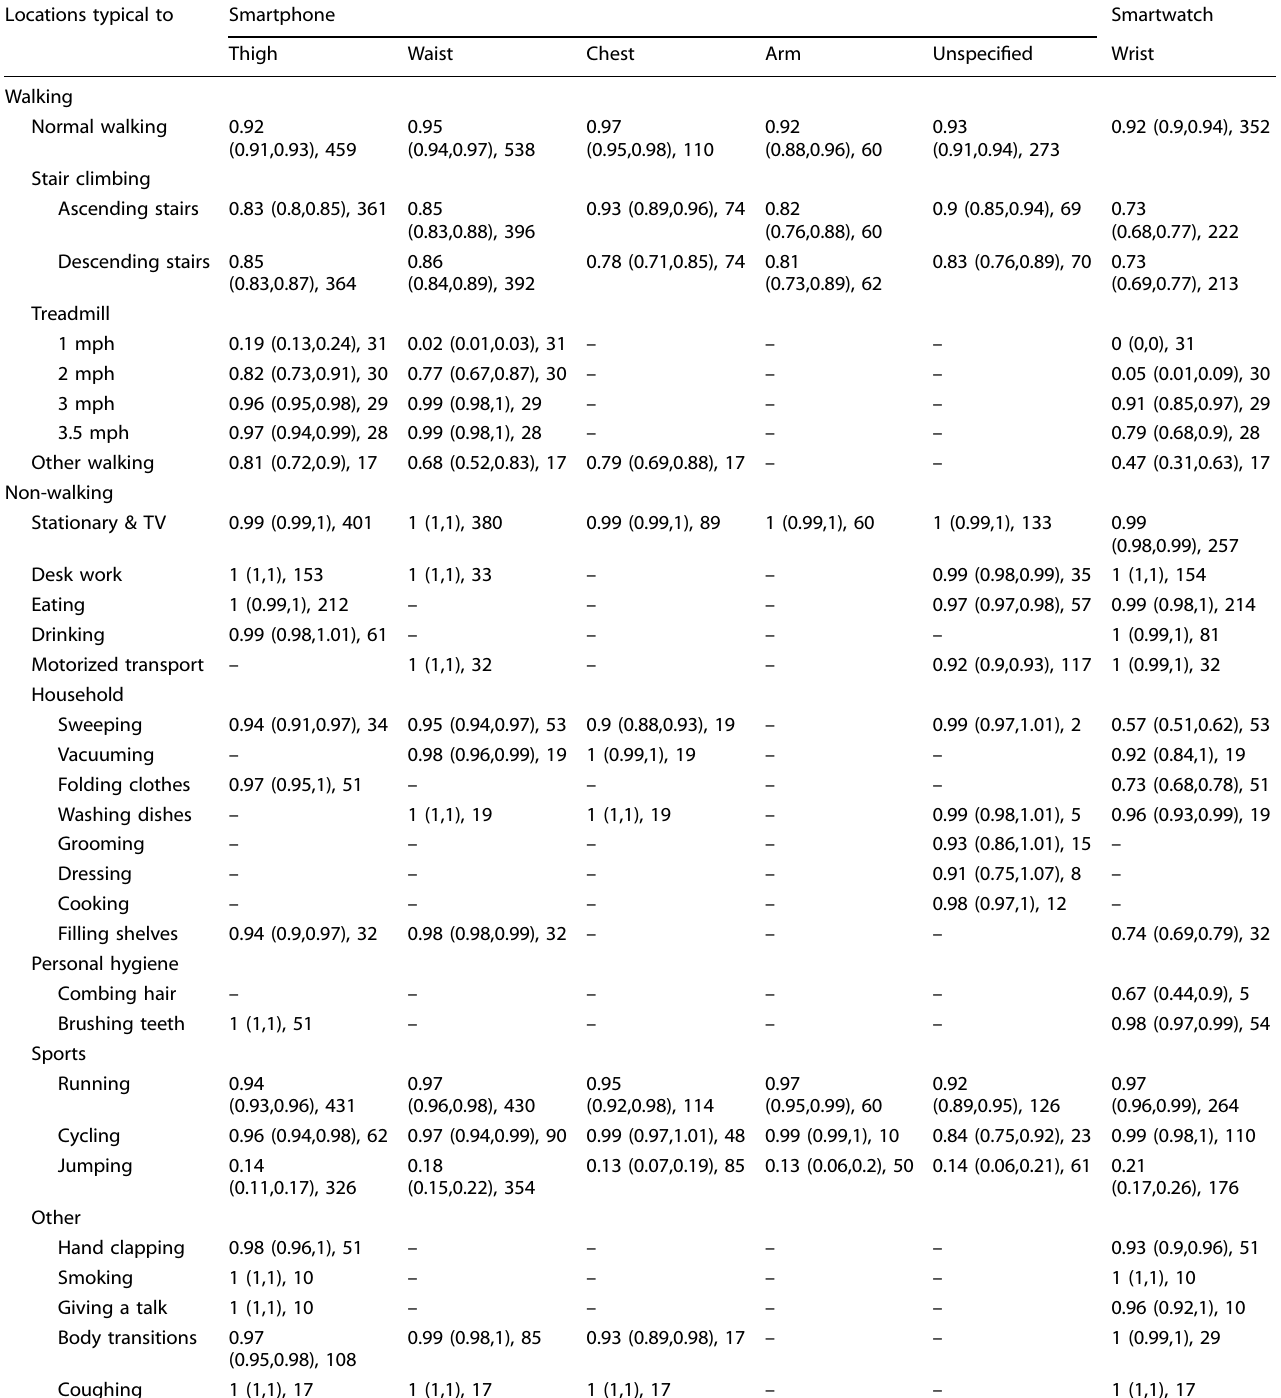
Table 2. Walking classi fi cation accuracy across all subjects and activities. Locations typical